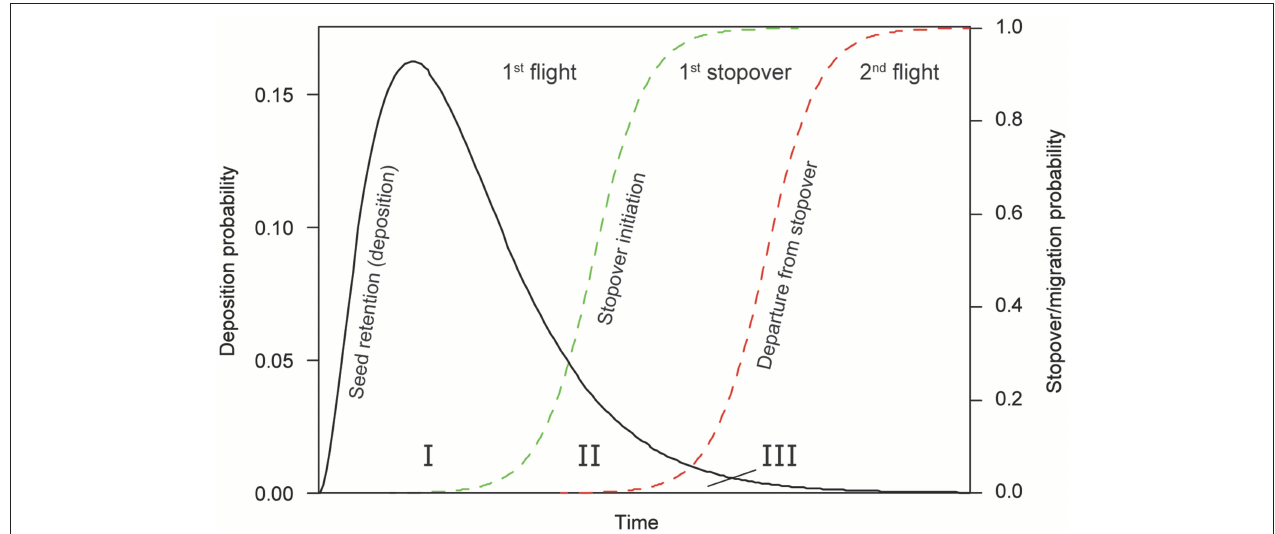
FIGURE 1 | Conceptual graph of seed dispersal during the migratory flight of a mallard. The seed retention time determines the excretion and therefore deposition probability, starting at t0 for seeds consumed just prior to departure. Seeds are deposited during the first migratory flight (phase I), the first stopover (phase II) or during the second migratory flight (phase III). The probability of arriving at (green dotted line) or departing from a stopover (red dotted line) is a function of time.